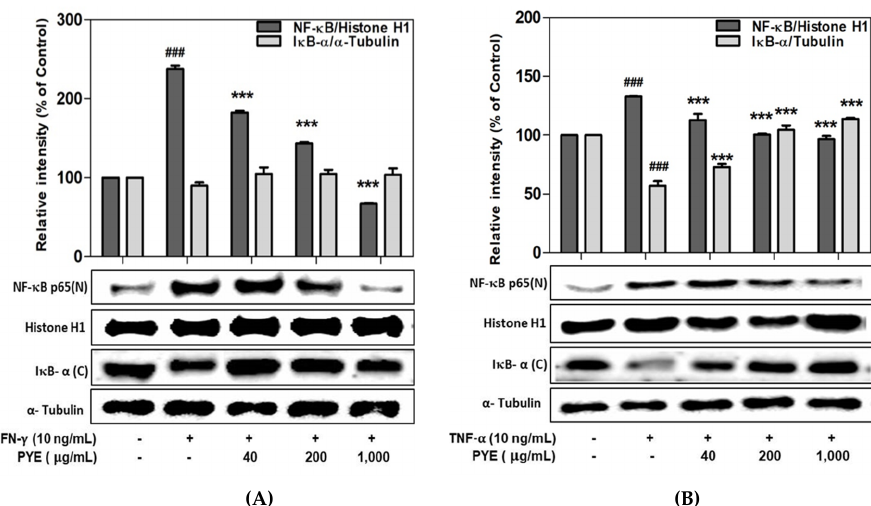
Figure5. E ff ectofPYEonthetranslocationofnuclearfactorNF-kB / IkB- α inducedbyIFN- γ ( A )orTNF- α ( B ) in HaCaT cells. HaCaT cells were incubated with various concentrations of PYE (40–1000 µ g / mL) and stimulated with IFN- γ or TNF- α (10 ng / mL). I κ B- α ( C ) in cytosol extract; NF- κ B (N) in nuclear extract. Expression of NF- κ B and I κ B- α was determined using Western blotting. Densitometry analysis presented as the relative intensity of housekeeping proteins was used as a loading control. Data are means ± standard deviation (SD) of independent experiments. Note: ### p < 0.001 control group vs. the IFN- γ or TNF- α (10 ng / mL)-treated group, and *** p < 0.001 IFN- γ or TNF- α (10 ng / mL)-treated group vs. PYE co-treated